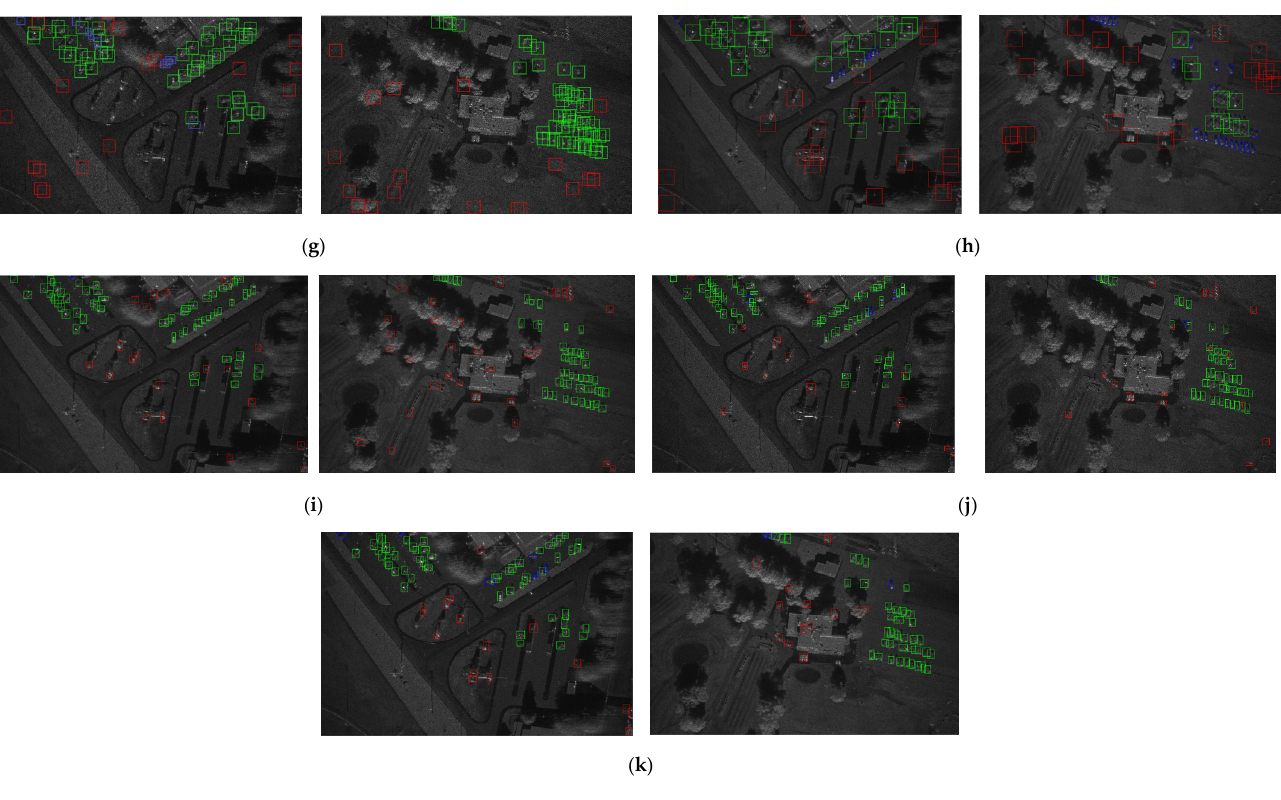
Figure 5. The detection results of the proposed FDDA and some related methods for the two test images in the miniSAR dataset, where the green, red, and blue rectangles indicate the correctly detected cars, the false cars, and the missing cars, respectively. ( a ) Gaussian-CFAR. ( b ) DAF. ( c ) HTCN. ( d ) Faster R-CNN. ( e ) DAPN. ( f ) YOLOv5. ( g ) Rosenberg’s method. ( h ) Zhang’s method. ( i ) STAC. ( j ) Soft Teacher. ( k ) Proposed FDDA. Table 3. The detection methods of different methods on the miniSAR